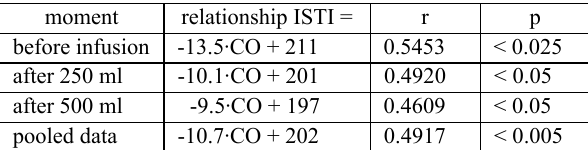
Table 2. Relationships between the Initial Systolic Time Interval ISTI (ms) and the Cardiac Output CO (L/min) at the three moments before, after the first and after the second intravenous fluid administration of 250 ml (N = 16). The coefficients of correlation r and the levels of significance p are also given. The last row gives the relationship for the pooled data (N =